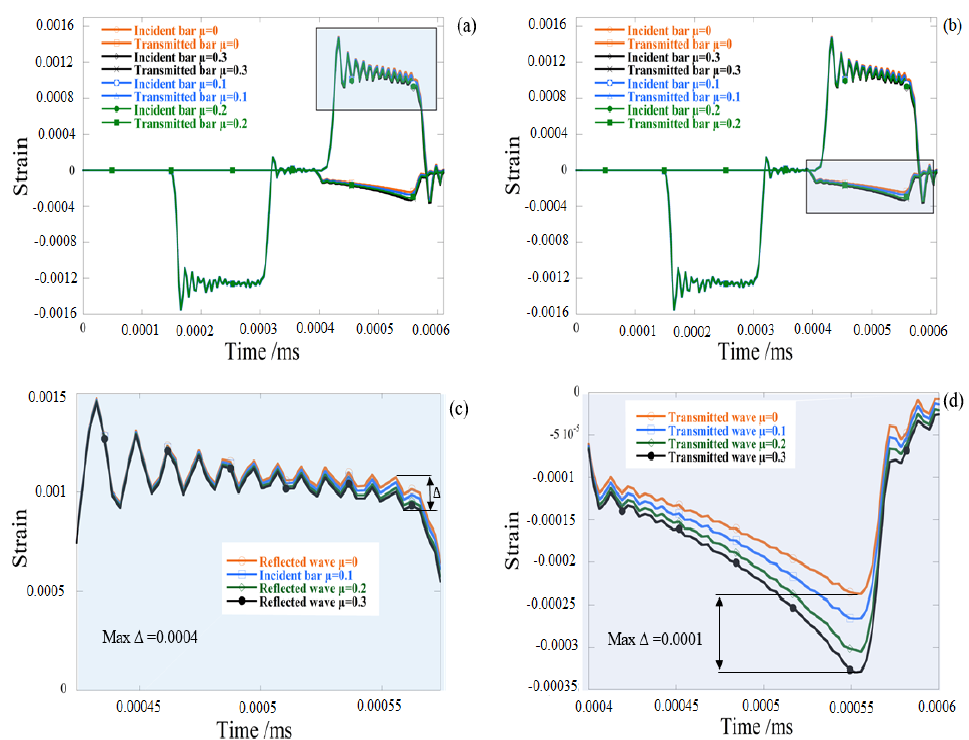
Figure 9. Comparison of reflected and transmitted waves under di ff erent friction conditions (cylinder sheet). ( a , b ) reflected and transmitted waves ( c ) reflected strain waves and ( d ) transmitted strain